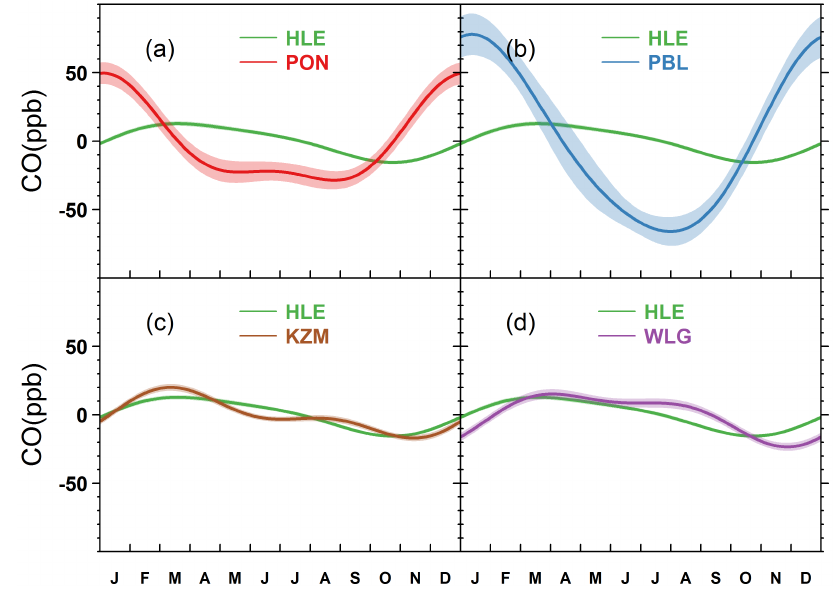
Figure 11. The mean CO seasonal cycles observed at (a) HLE and PON, (b) HLE and PBL, (c) HLE and KZM, and (d) HLE and WLG. For each station, the mean seasonal cycle is derived from the harmonics of the smoothed fitting curve in Fig. 10. Shaded area indicates the uncertainty of the mean seasonal cycle calculated from 1 SD of 1000 bootstrap